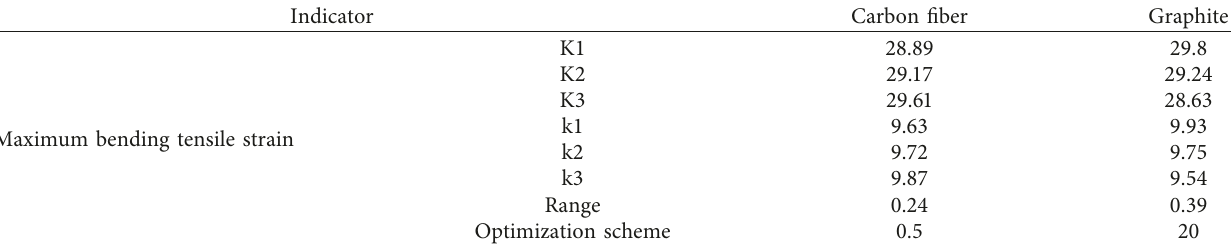
Table 10: Range analysis of trabecular bending